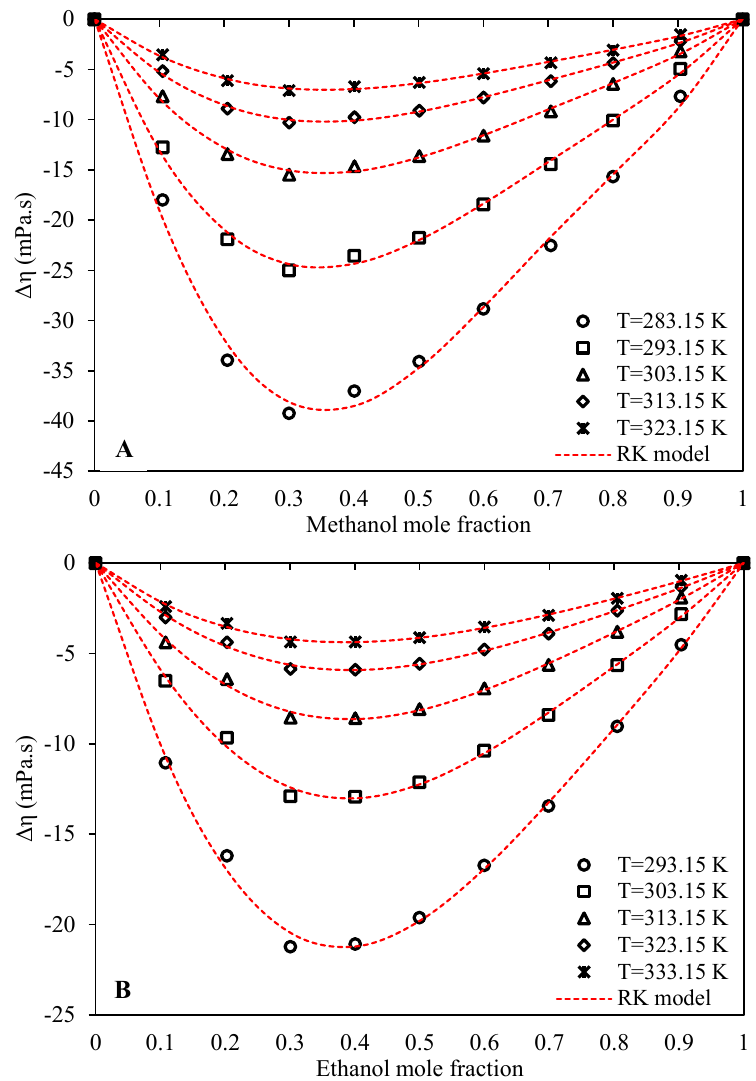
Figure 5. Behavior of viscosity deviation from ideality with respect to alcohol concentration at the pressure of 100 kPa (A: Ethaline (1 ChCl:2 ethylene glycol) + methanol, B: Ethaline (1 ChCl:2 ethylene glycol) + ethanol).